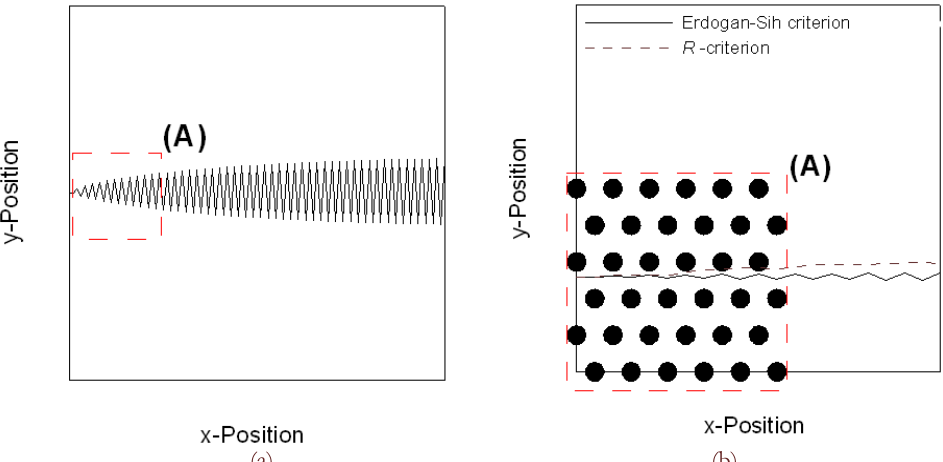
Figure 10: (a) Path of an initially straight crack developing at one-third distance between two lines of inclusions in an infinite plane  . (b) Detail of the crack path at the microscale where the distribution of inclusions is under remote uniform tensile stress 0 y